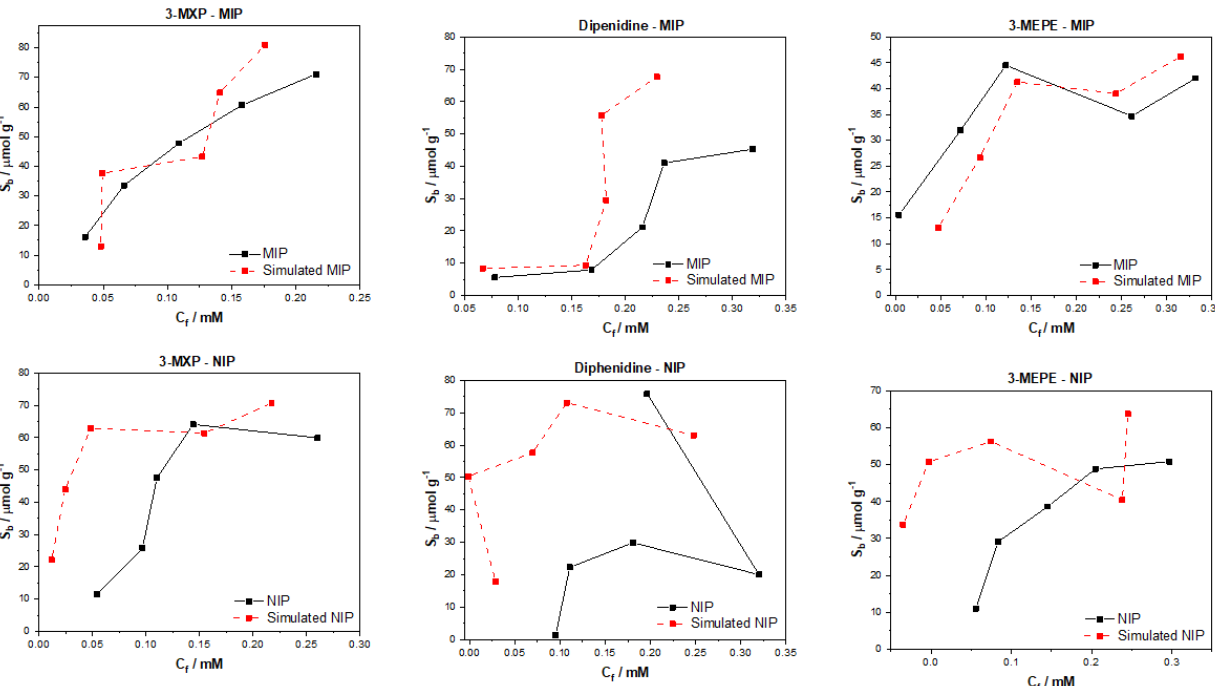
Figure 6. Multitask regressor with the RdKit featurizer simulated and experimental binding isotherms for MIP and NIP in regard to the binding of 3-MXP, diphenidine, and 3-MEPE.